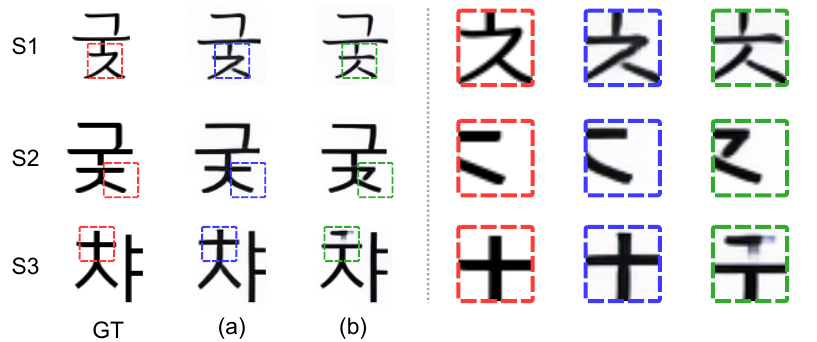
Figure 9. Examples of the generated images for unseen font: GT: image of ground truth font, ( a ): generated images without ResBlock, ( b ): generated images with ResBlock ( n =